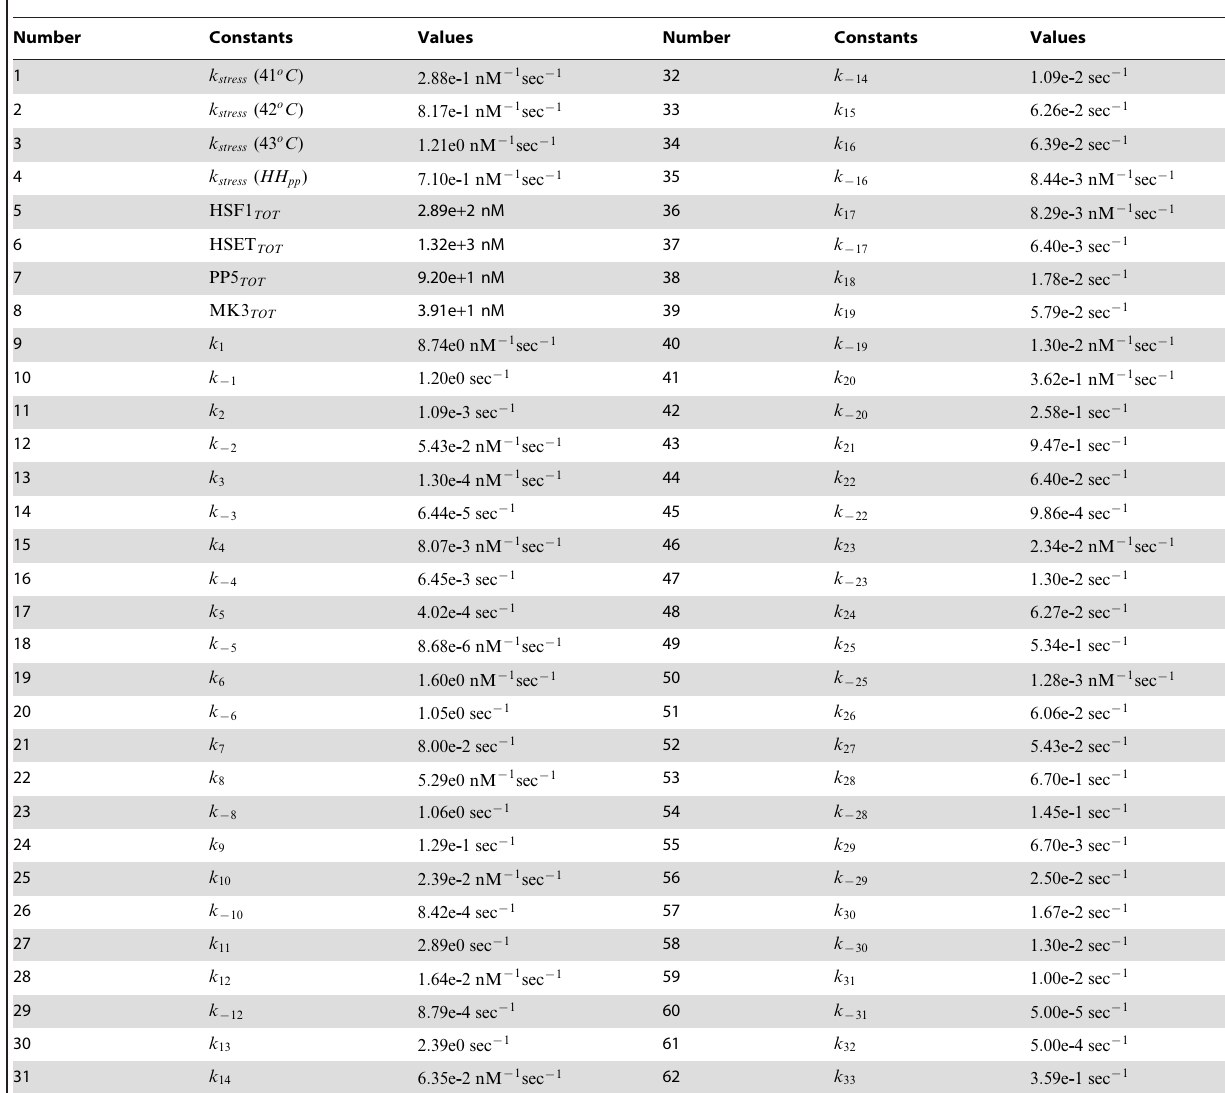
Table 1. Kinetic parameters used in the bifurcation analysis and numerical integration.